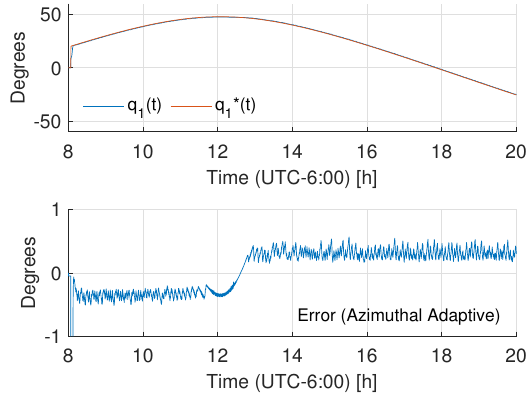
Figure 12. Tracking behavior for the azimuthal axis.